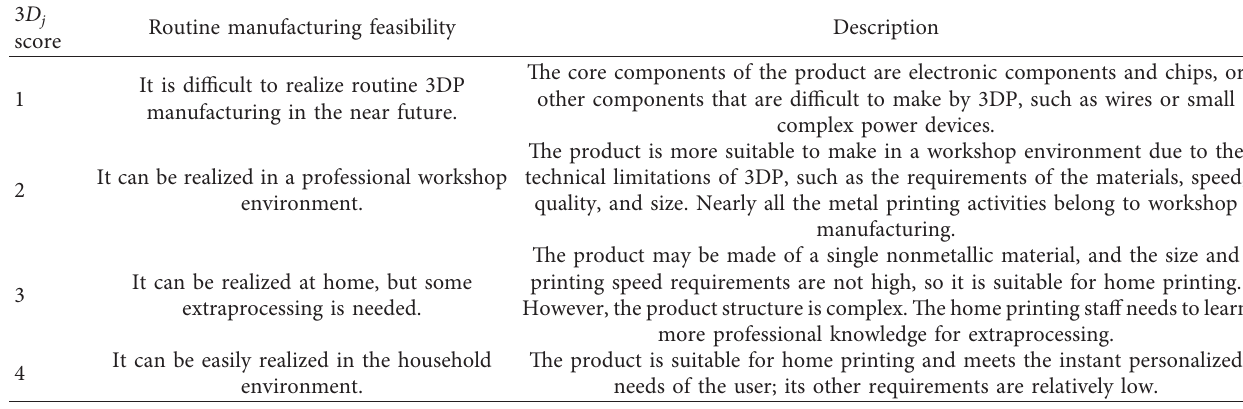
Table 3: 3DP feasibility score for routine manufacturing of different products. Data source: Wohlers reports [34, 39–42], Petersen et al. [21], and Laplume et al.